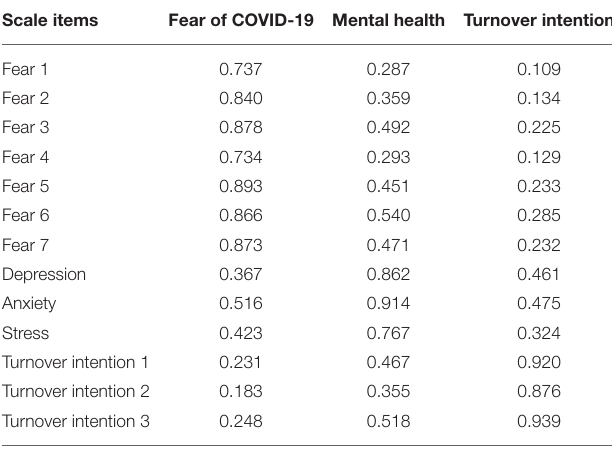
TABLE 4 | Cross-loadings of constructs. Scale